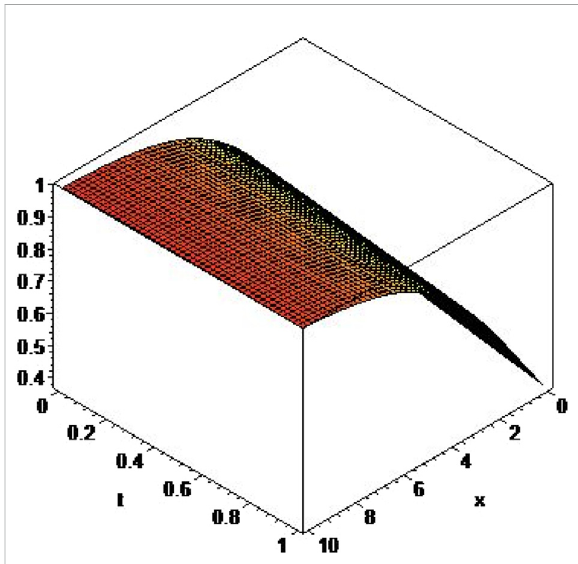
FIGURE 1 Figure of u4 in (Eq. 4.14) with μ = 2, 0 < t < 1, and 0 < x < 10.